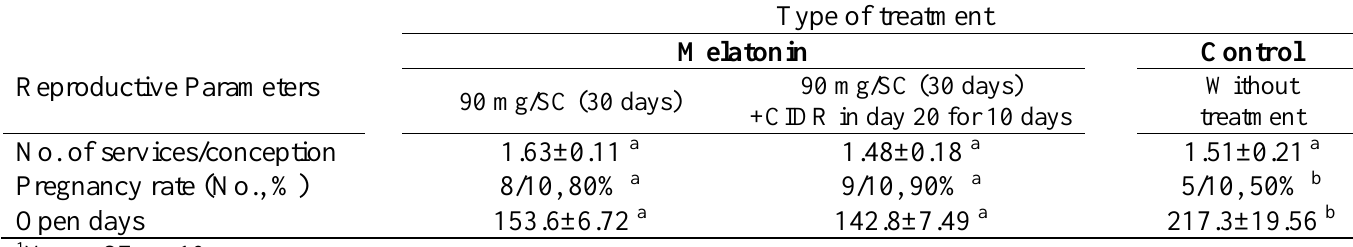
Table 2. Number of services per conception, pregnancy rate, and open days in anestrous lactating Iraqi buffaloes subjected to melatonin with or without progesterone control internal drug release (CIDR)